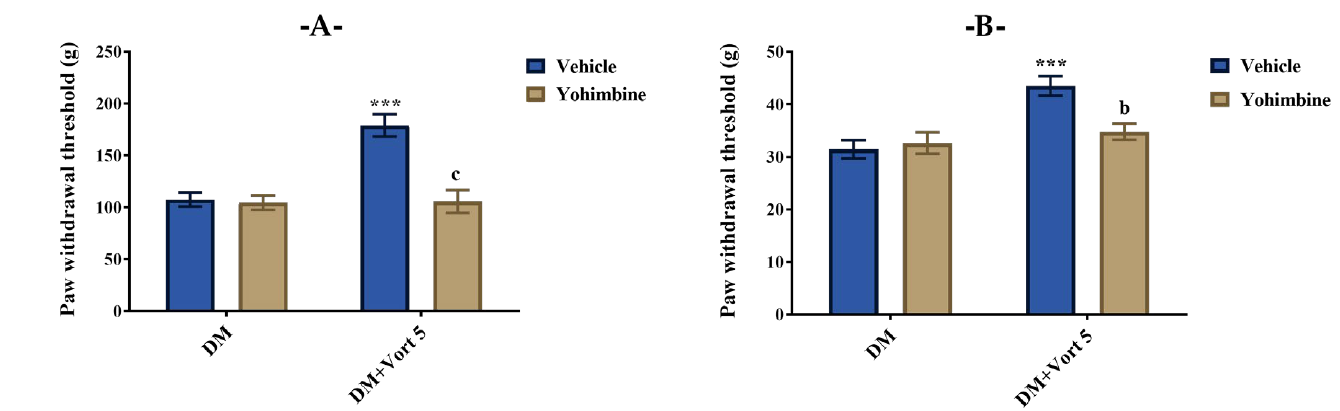
Figure 7. The effects of yohimbine pre-treatment on antihyperalgesic ( A ) and antiallodynic ( B ) responses induced by the administration of 5 mg/kg vortioxetine in the Randall-Selitto and Dynamic plantar tests, respectively. Values are given as mean ± S.E.M. Significant difference against vehicle-administered diabetic group (DM) *** p < 0.001; significant difference against vortioxetine- administered diabetic group (DM+Vort 5) b p < 0.01; c p < 0.001. Two-way ANOVA, post hoc Bonferroni multiple comparison test, n = 8.